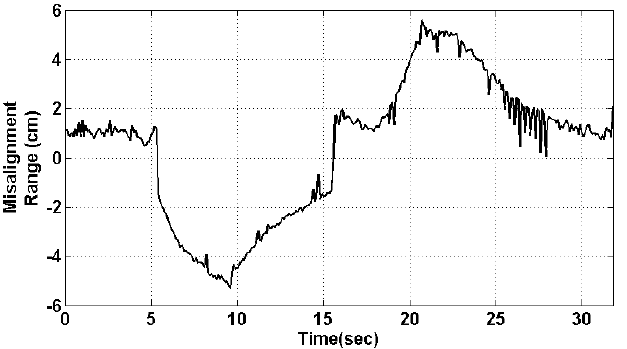
Figure 25. Estimated misalignment range from the ACAS controller based on voltage readings and the left/right position given by the sensor coil.